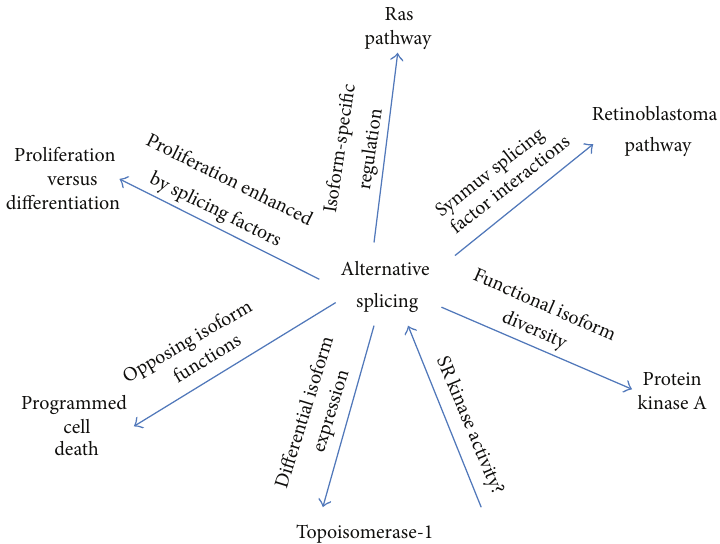
Figure 2: Connections between alternative splicing in C. elegans and pathways homologous to those that cause excessive cell proliferation or apoptosis in humans, as reviewed in this